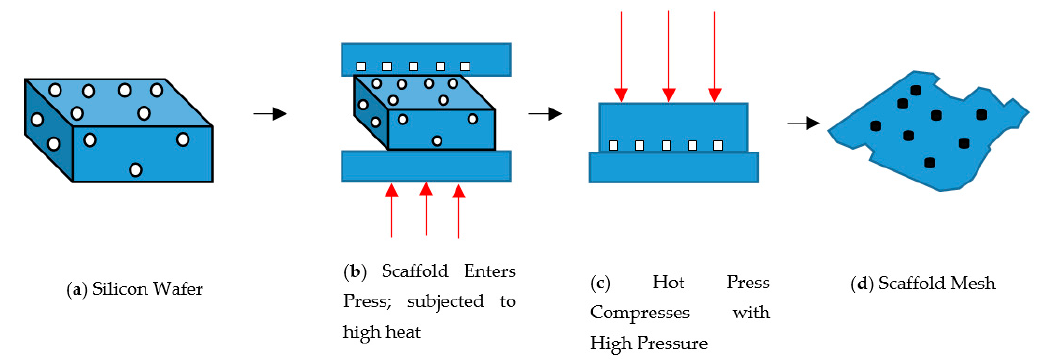
Figure 5. Overview of Compression method for Metal-Ceramic Scaffold Fabrication [128].